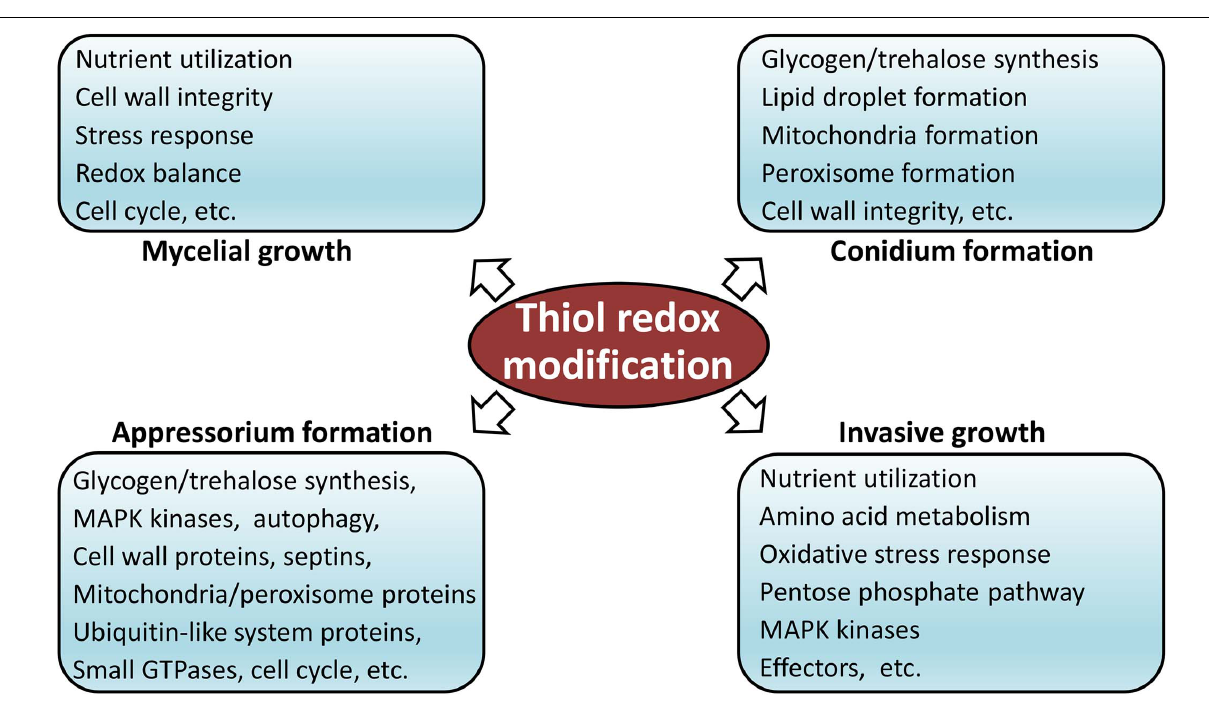
FIGURE 5 | Model of thiol redox-modification-regulated development and infection of M.